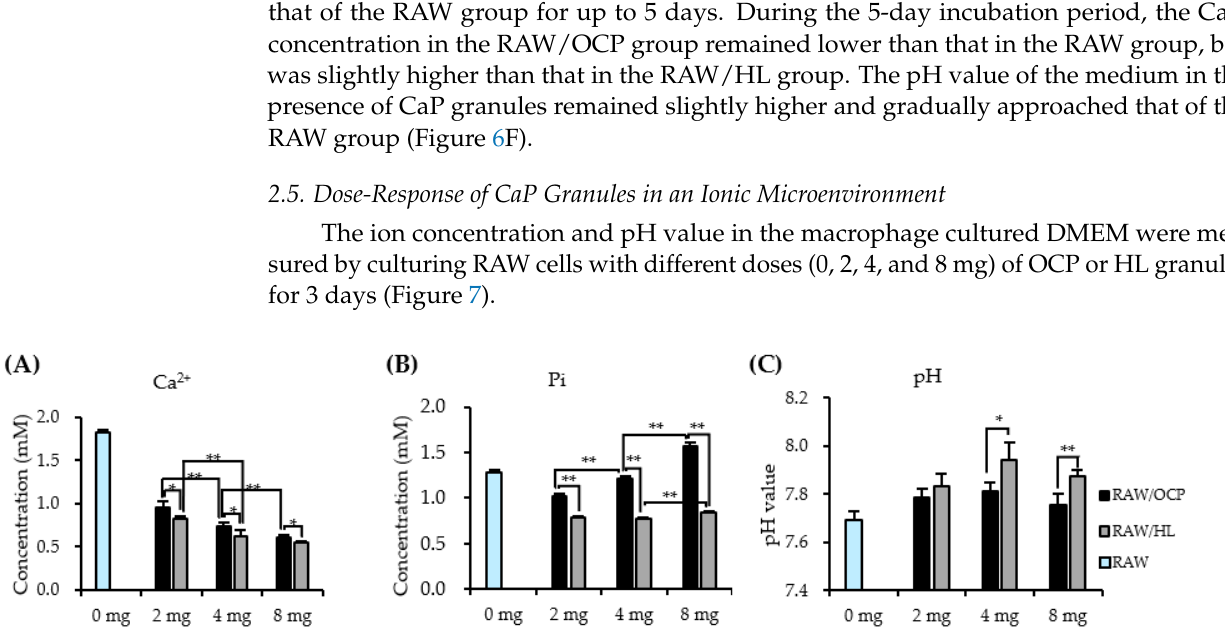
Table 1. Solution composition and degree of supersaturation (DS) of macrophage culture medium before and after the immersion of OCP or HL granules.